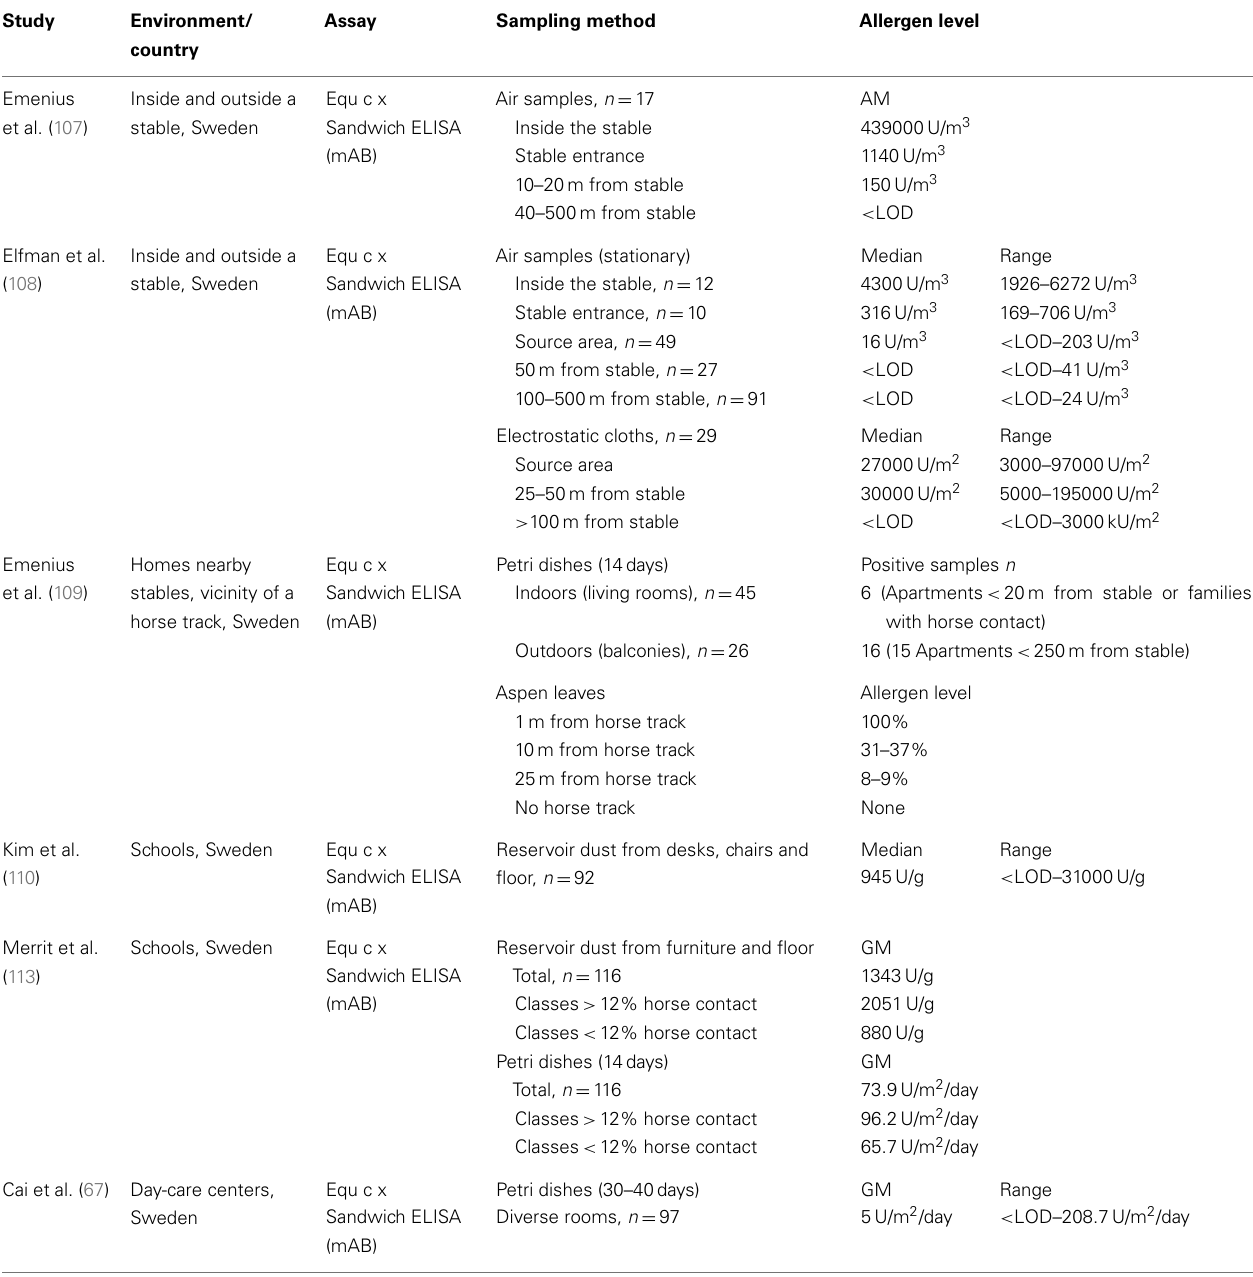
Table 5 | Studies related to exposure assessment to horse